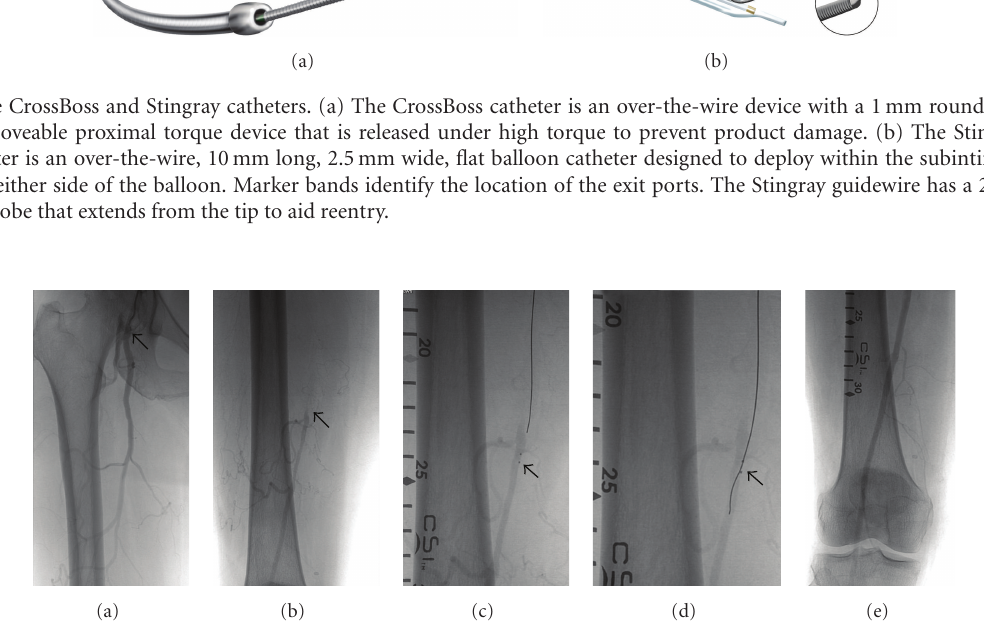
Figure 2: Successful use of the CrossBoss and Stingray catheter. (a) Angiography showing occlusion of the right superficial femoral artery (SFA) at its ostium (arrow). (b) Angiography showing the distal SFA reconstituted by collateral flow from the right profunda. (c) Wire inside the StingRay balloon catheter (arrow). The catheter is within the subintimal space distal to the SFA occlusion. The two radio-opaque dots are the two exit ports on the catheter. (d) Wire advanced through the StingRay balloon catheter (arrow) exiting into the true lumen of the distal SFA. (e) Postinterventional final angiogram revealing antegrade flow through the previously occluded